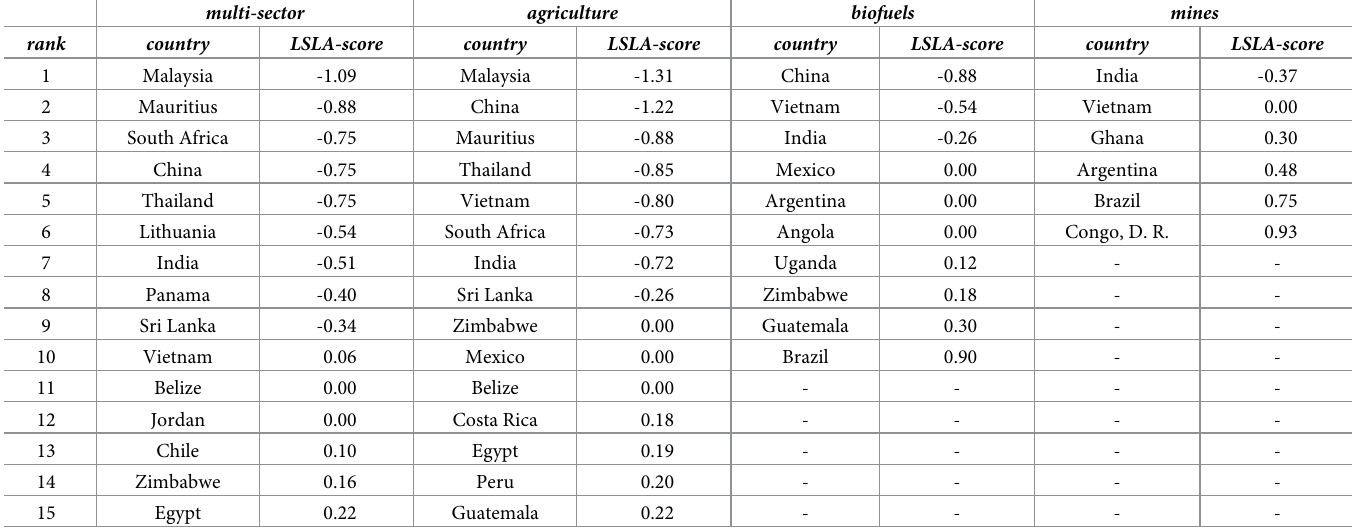
Table 5. Top-ranked countries by LSLA-score in the multi-sector , agriculture , biofuels and mines networks. Sink (i.e., pure investors) and source (i.e., pure target) nodes are excluded from the ranking, in compliance with the fact that only double role countries are regarded as potential anomalies. An investor orientation of the ranking has been chosen (i.e., lower scores first) in order to emphasize similarities with the results produced by LurkerRank